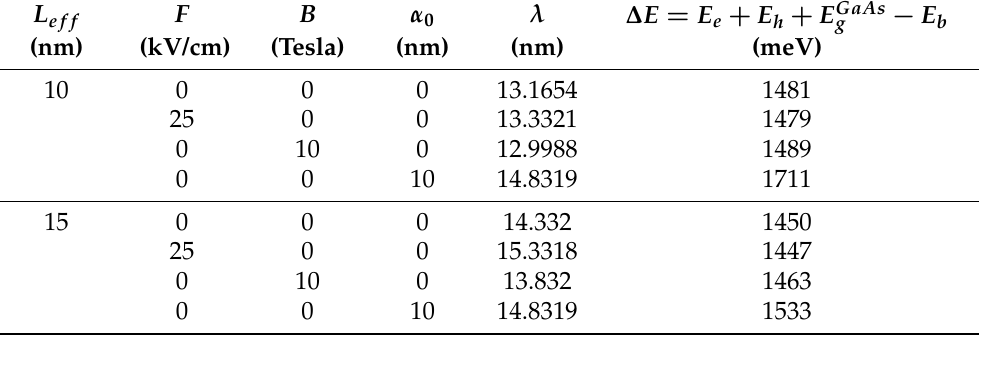
Table 2. The variations of λ and ∆ E parameters versus well sizes and external fields for V 2 ( z e ( h ) ) potential.